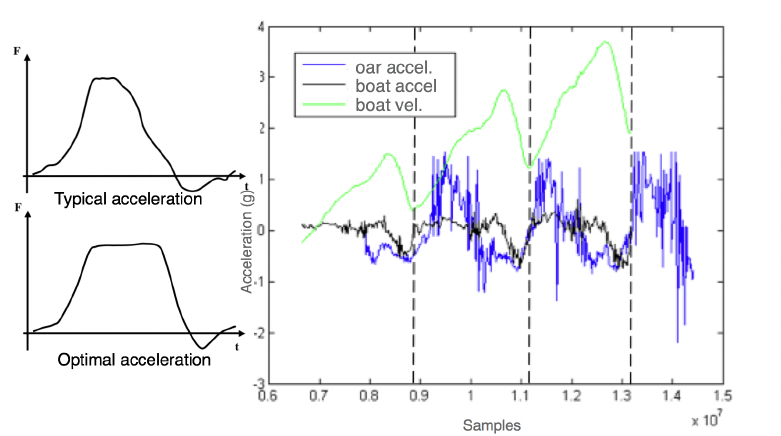
Figure 12. Comparison of boat acceleration, boat velocity, and oar acceleration.